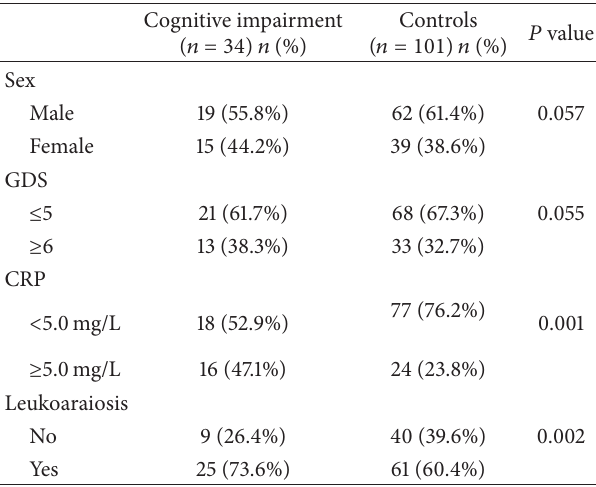
Table 2: Chi-square for categorical